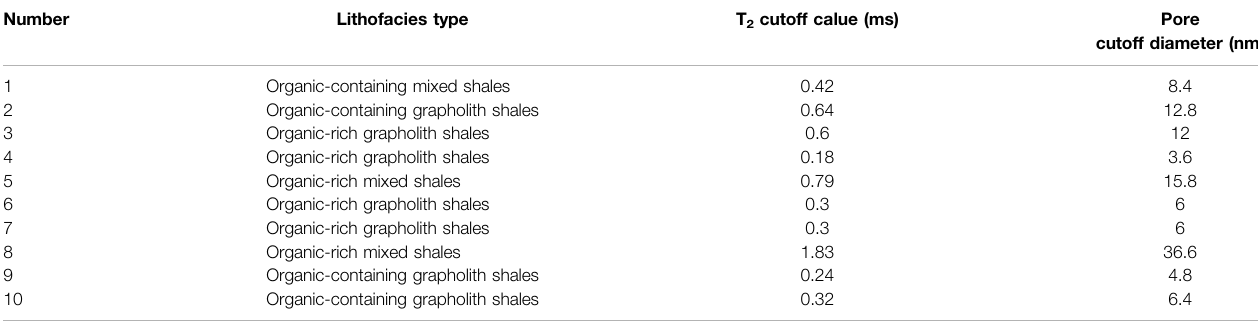
TABLE 9 | Sample experiment results of theT2 cutoff value and pore cutoff diameter.